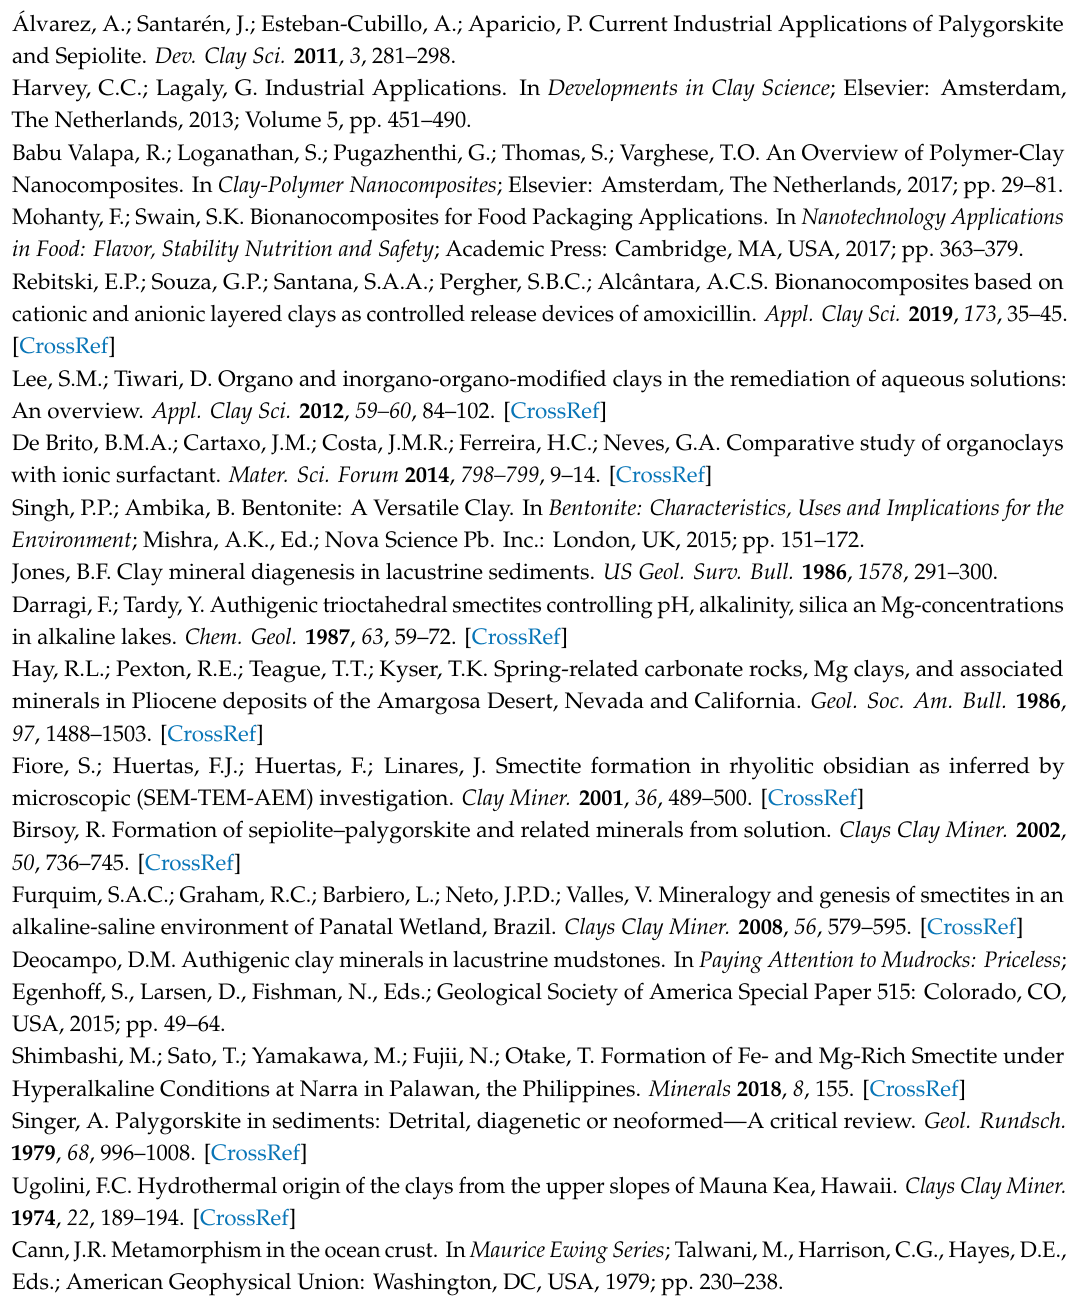
Figure S1: XRD-patterns of sample ROS, Table S1: Correlation matrix of major oxides, Table S2. Content of minor and trace elements in Spanish